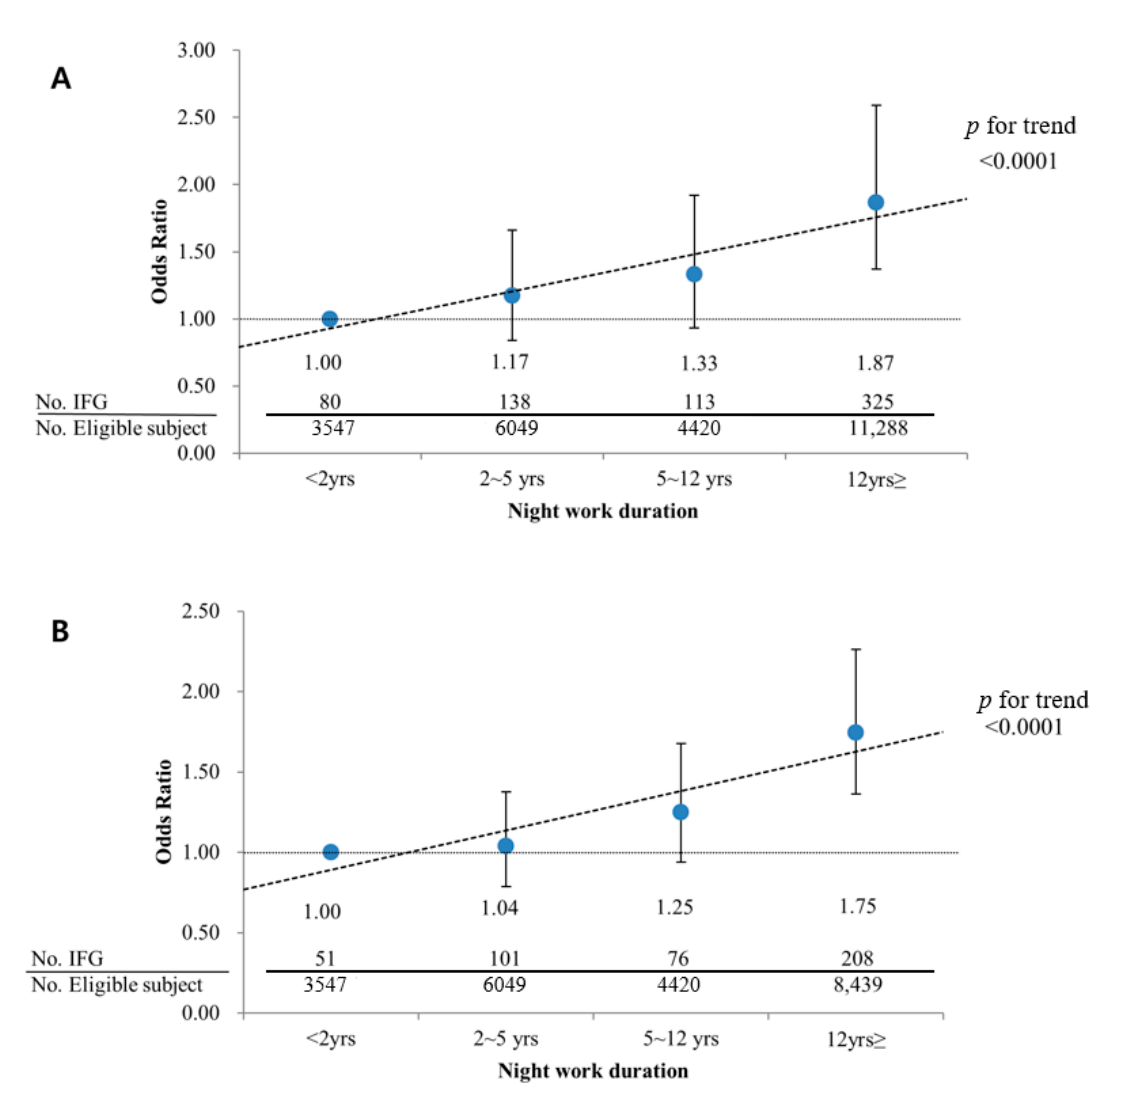
Figure 2. Adjusted odds ratio of IFG (Impaired fasting glucose) according to work duration, stratified by obesity (either waist circumference or BMI, alternatively) among subjects over 40 years old. ( A ) subjects without obesity (BMI); ( B ) subjects without abdominal obesity (waist circumference). * Adjusted for age, sex, exercise, alcohol habit, smoking, work duration, job type, hypertension, dyslipidemia. Logistic regression analysis was used to estimate the p for trend of odds ratios for IFG with ascending order of duration of night work as continuous variable option.